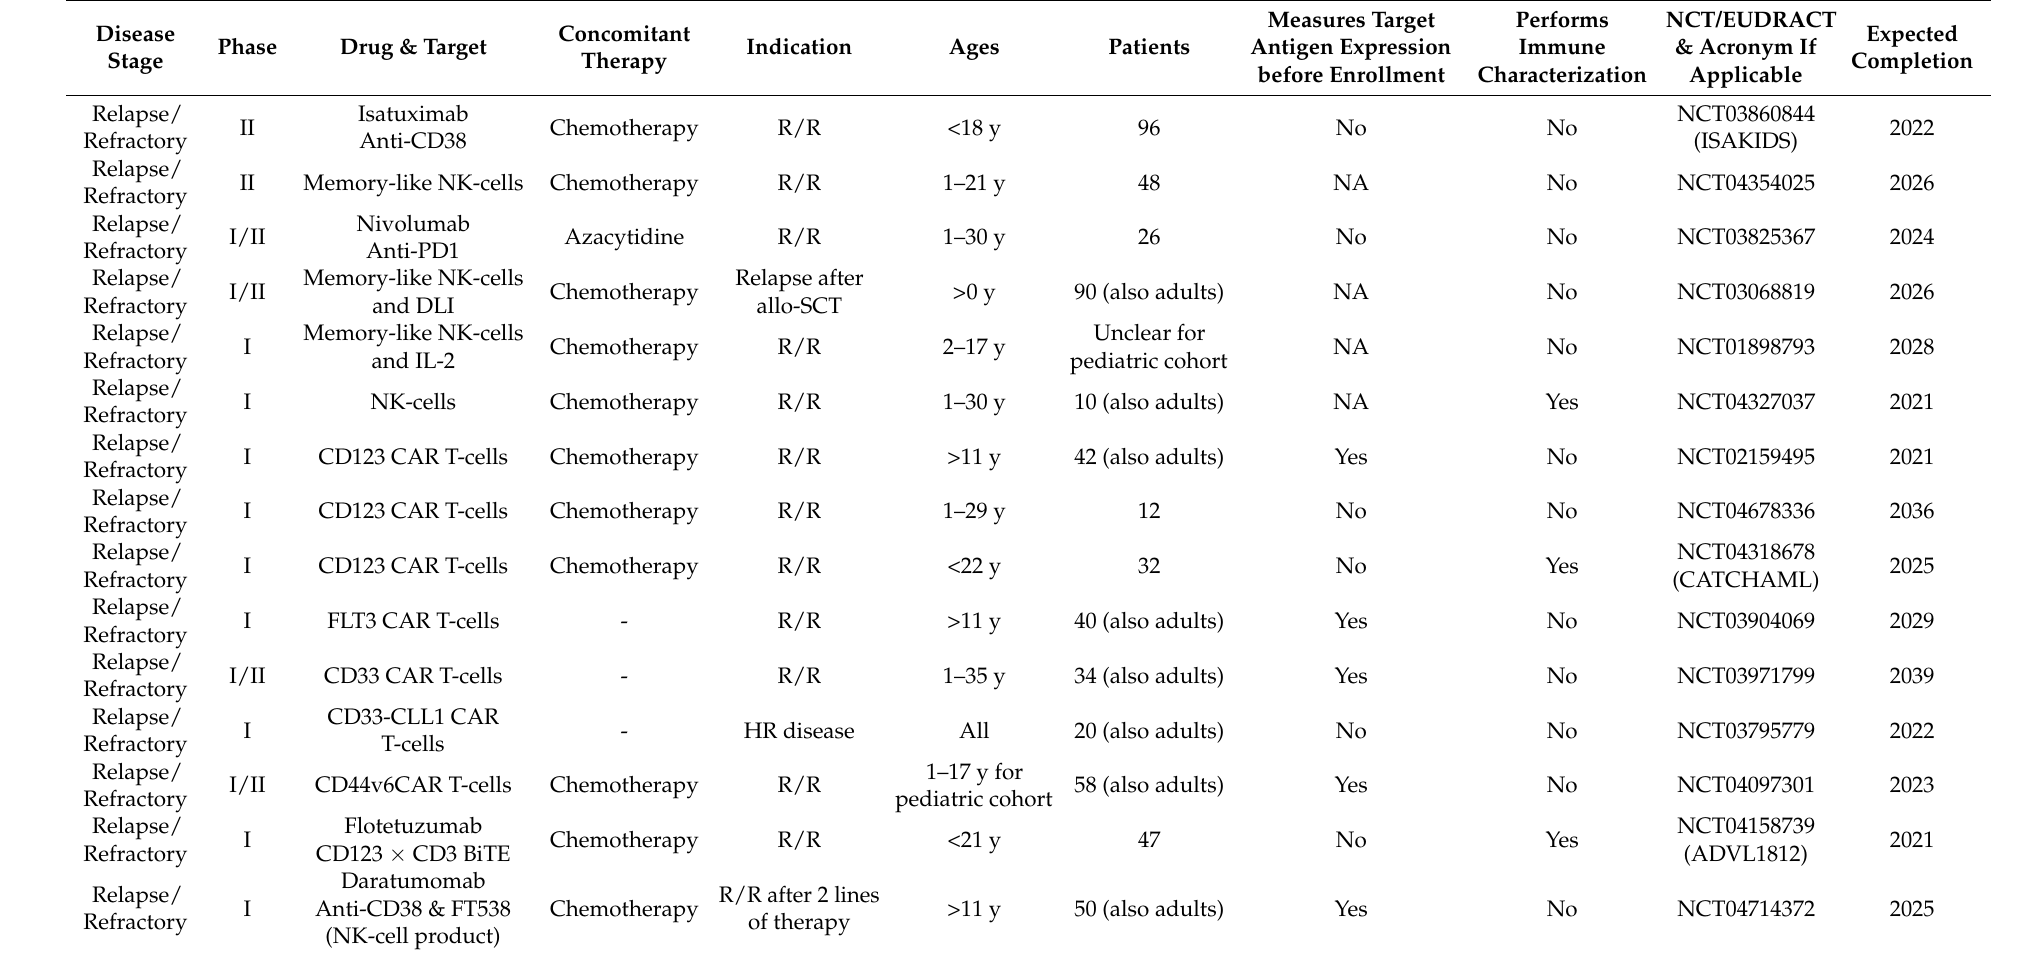
Table 2. Overview of currently ongoing or planned immunotherapy trials for pediatric